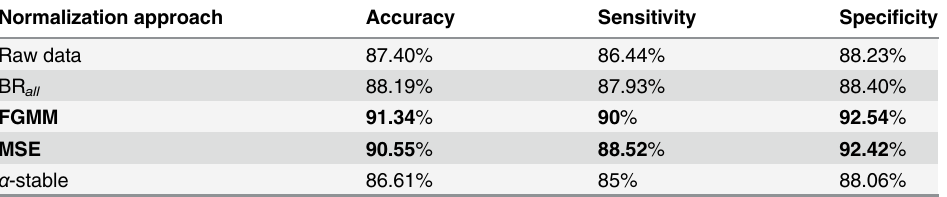
Table 3. Comparison between the accuracy rates achieved with the proposed intensity normalization methodologies based on VAF approach and linear SVM classifier. Normalization approach